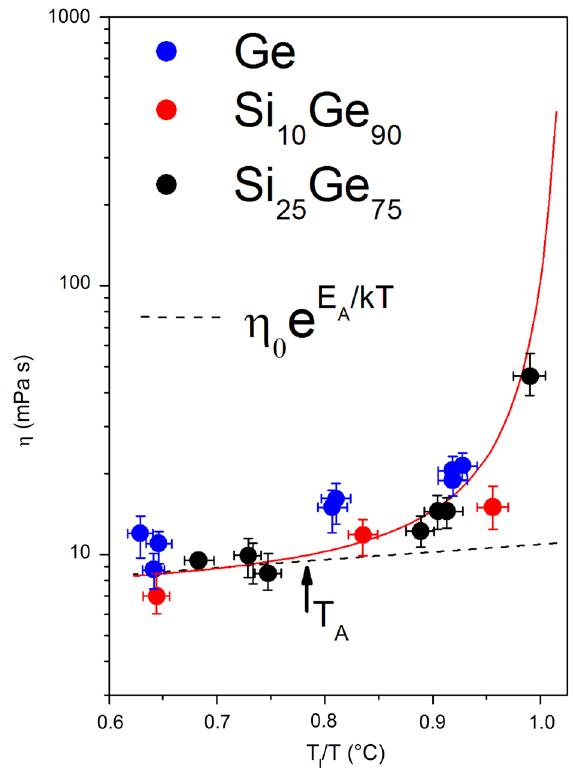
Fig. 5 Viscosities η measured at different temperatures for Ge, Si 10 Ge 90 , and Si 25 Ge 75 melts, showing Arrhenius-type behavior ( dashed lines ) with a crossover temperature T A between simple and cooperative liquid.